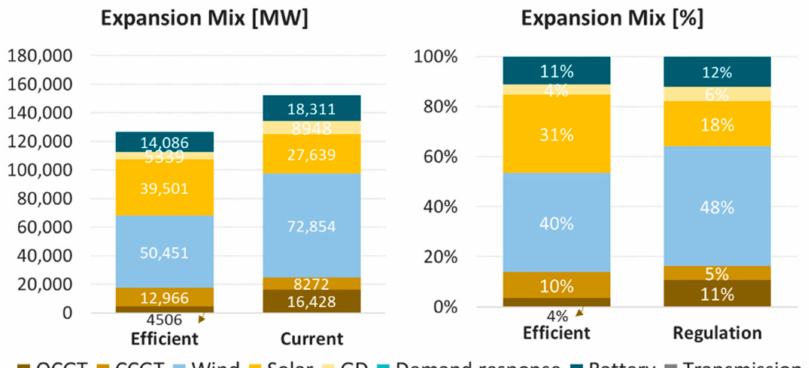
Figure 16. Comparison of total expansion between